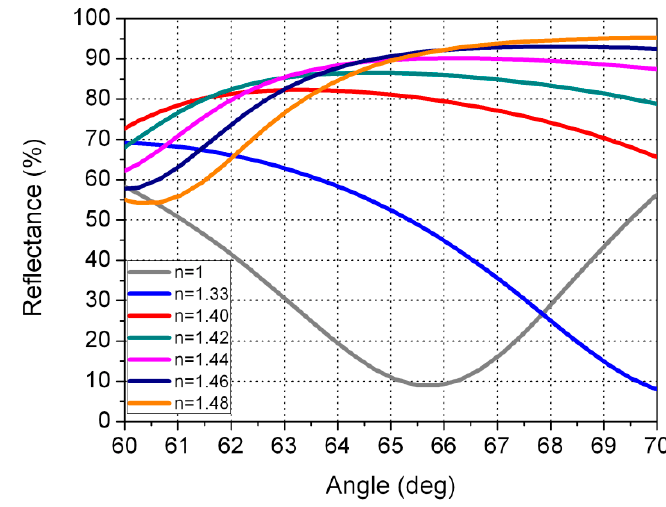
Figure 6. Detail of Figure 6. Reflectance curves from Figure 5 for incidence angles of between 60° and 70°.